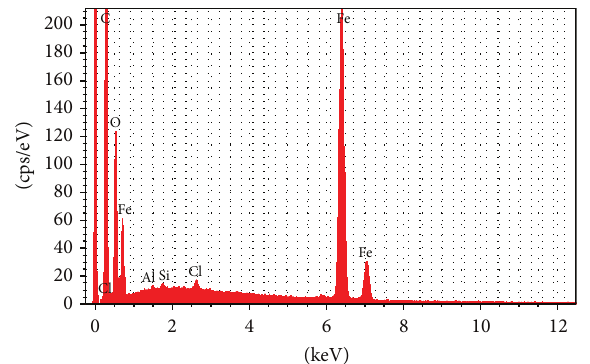
Figure 5: Energy dispersive spectroscopy (EDS) spectra of mag- netite and graphite milled for